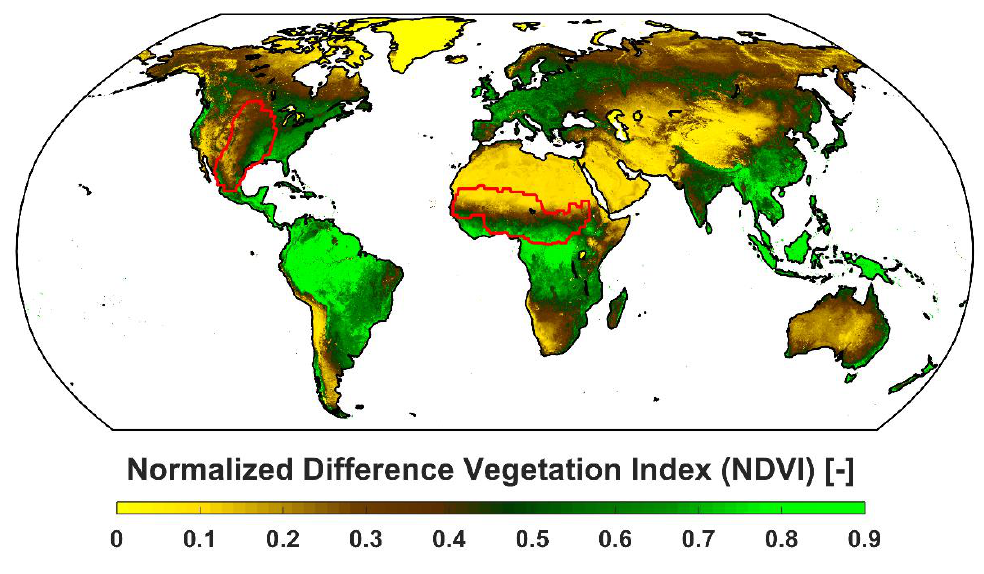
Figure 1. Mean global NDVI values, including the two hotspots used in the TCA and R value evaluation based on [40], over the Sahel and central Great Plains.